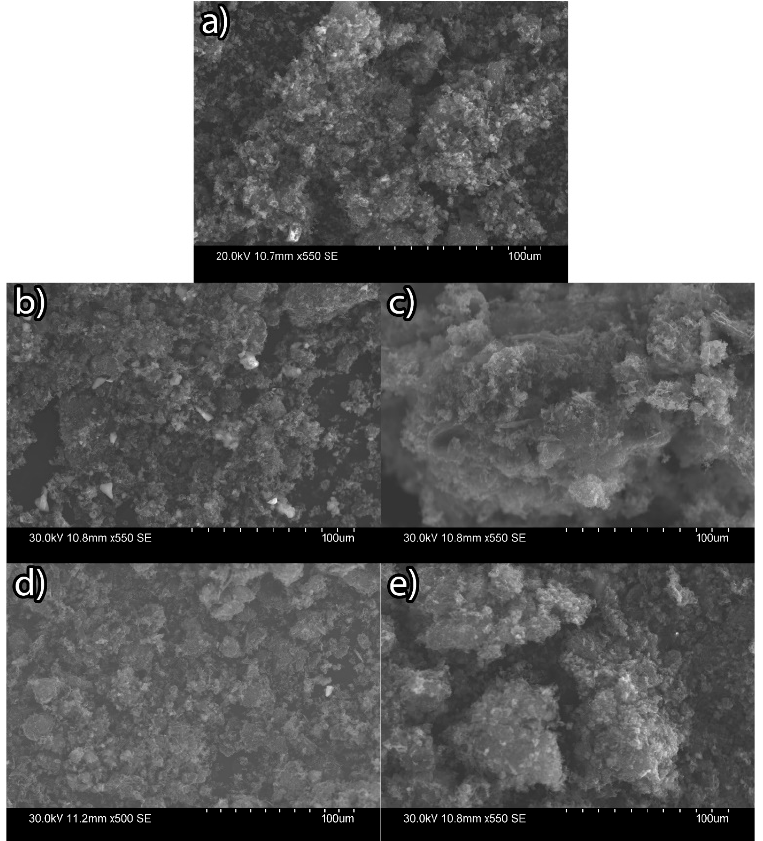
Figure 2. SEM images highlighting the morphologies of ( a ) Au-600; ( b ) Cu-600; ( c ) G-700; ( d ) G-600-30; and ( e ) G-600-09.